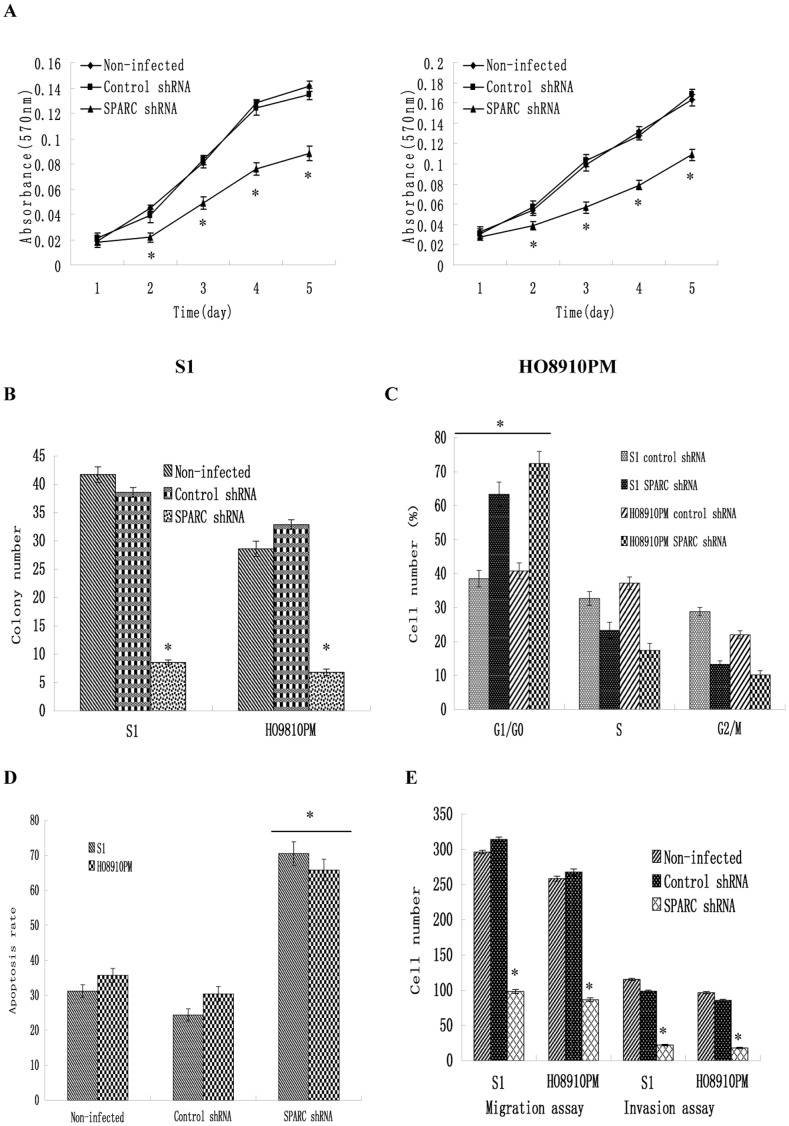
Effect of SPARC knockdown in highly invasive cell line S1 and HO8910PM on cell growth, colony formation, apoptosis, migration and invasion.(A) Cell proliferation as examined by MTT assay. (B) Anchorage independent growth as measured by soft agar colony formation assay. (C) Cell-cycle distributions as measured by flow cytometry. (D) Cell apoptosis as measured by Annexin V-PI assays. (E) Cell migration and invasion assay using Boyden chambers. *P<0.05 versus control.